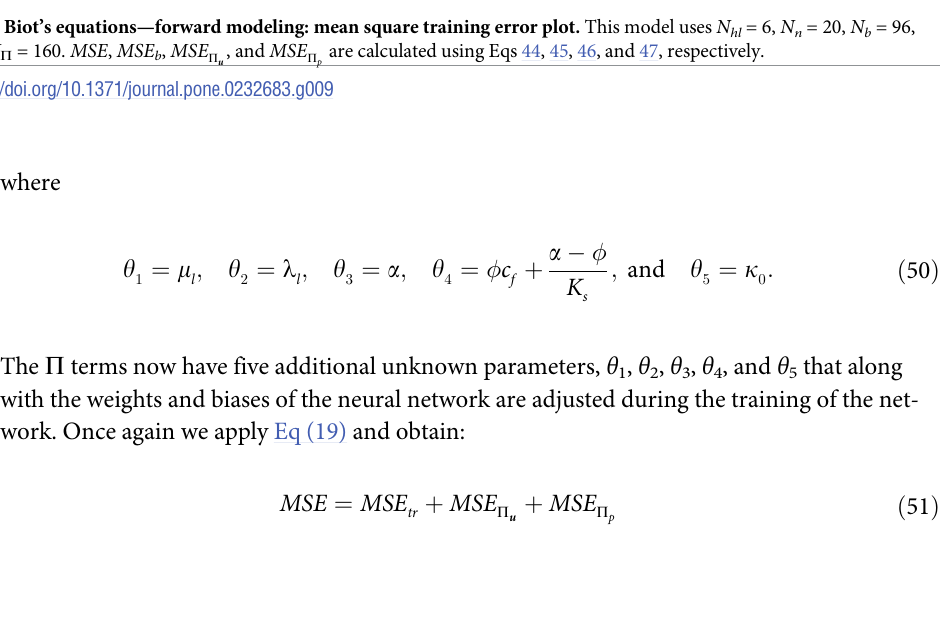
= 6, N = 20, N = 96, hl n b